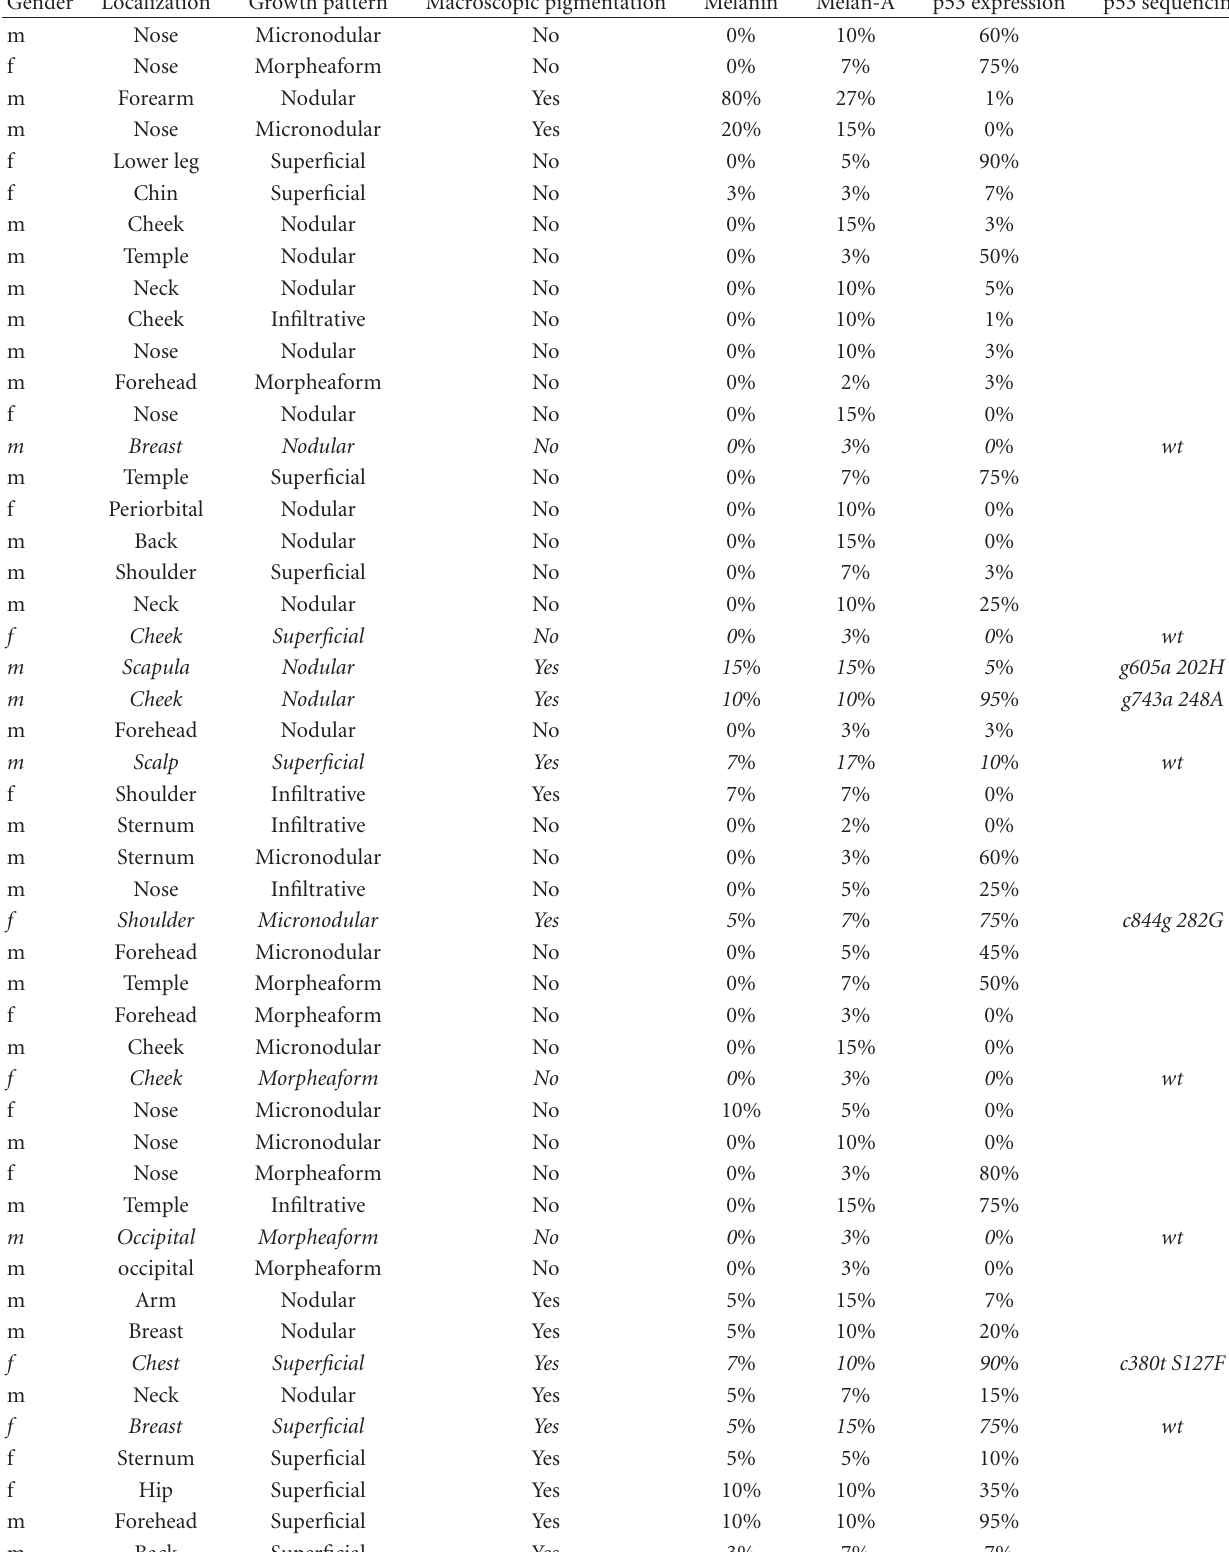
Table 1: Clinical, microscopic, immunohistologic, and sequencing data of the basal cell carcinomas analysed in this study. Gender Localization Growth pattern Macroscopic pigmentation Melanin